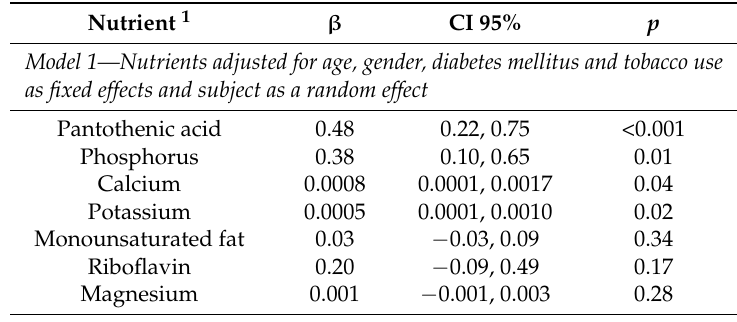
Table 3. Generalized linear mixed models between nutrient intakes and CAC among participants included in the study.